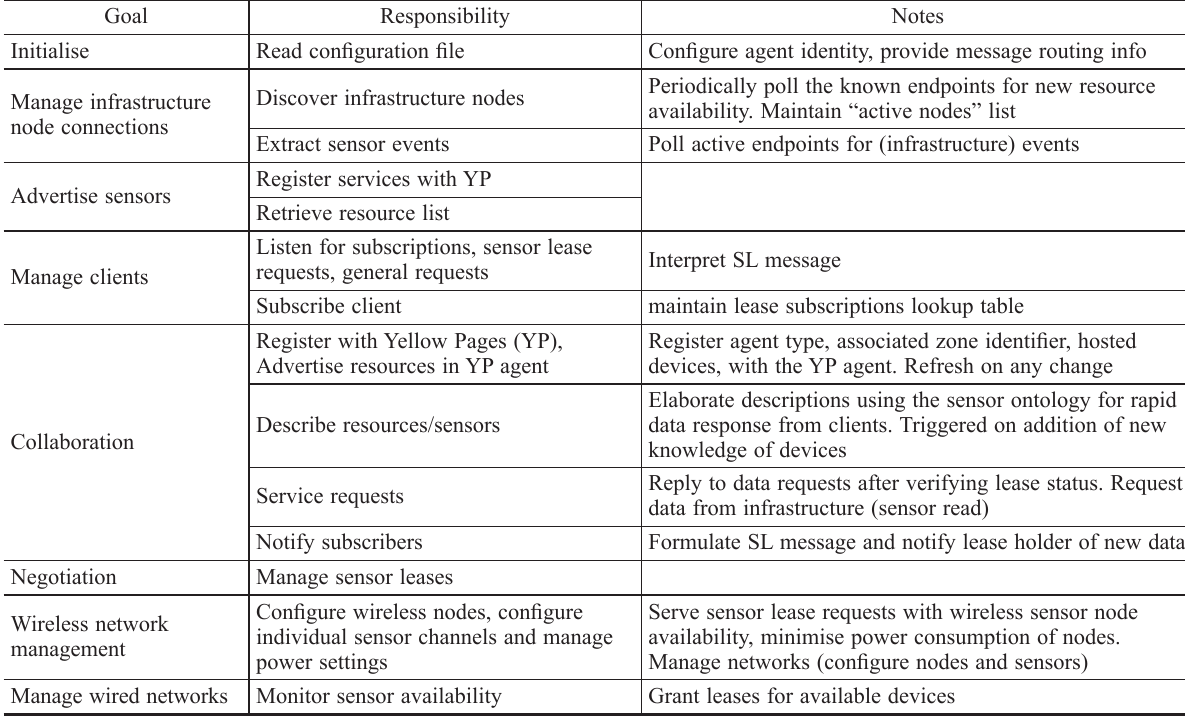
Table 3. sensor node high level agent goals